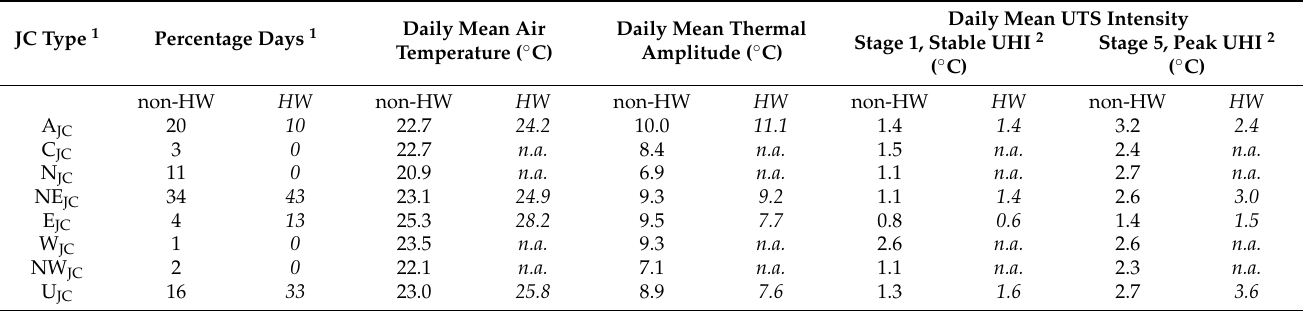
Table 6. Characterization of the daily mean air temperature, thermal amplitude and UTS intensity of “N” and “N var” days, per Jenkinson–Collison (JC) types, summer (JJAS, 2005–2014).